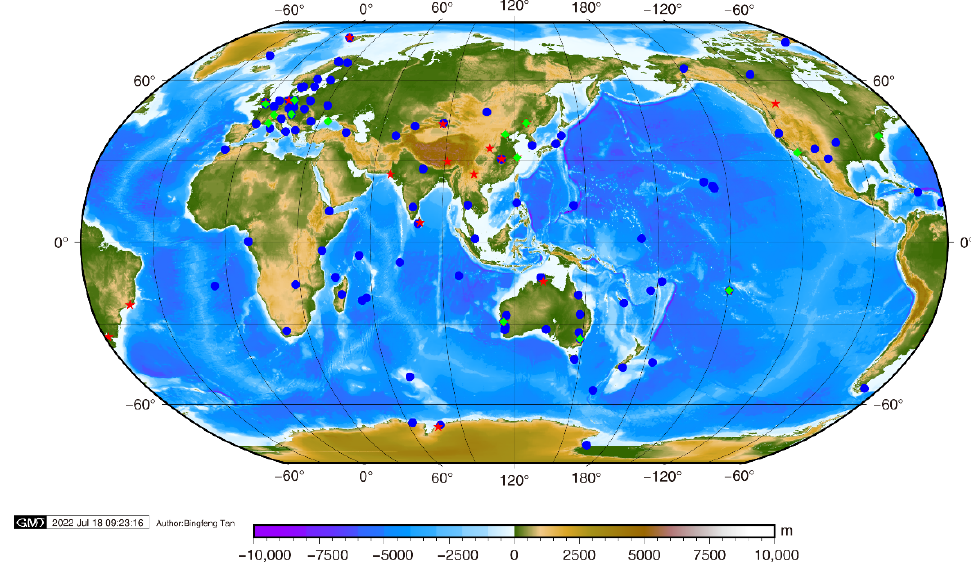
Figure 1. Tracking stations used in multi-GNSS real-time POD and SLR validation. The stations are remarked by blue circles, red five-pointed stars and green diamonds for IGS, iGMAS and SLR tracking stations, respectively.